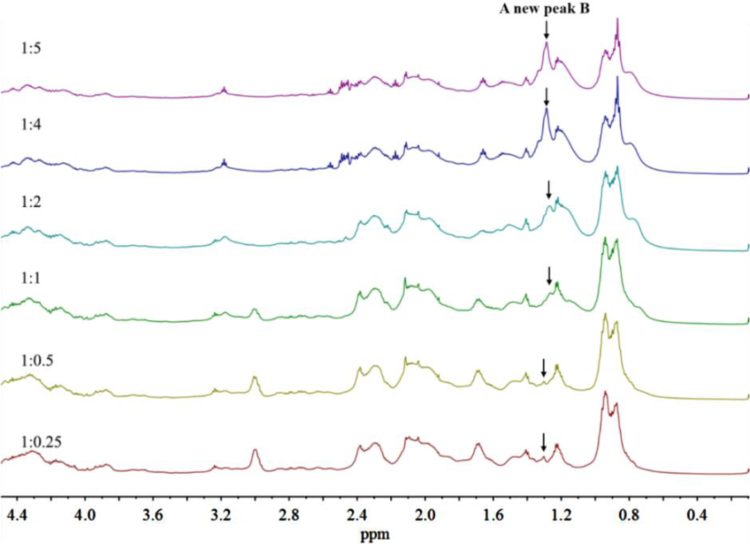
Stacked 1H NMR spectra of C8-caseinate.